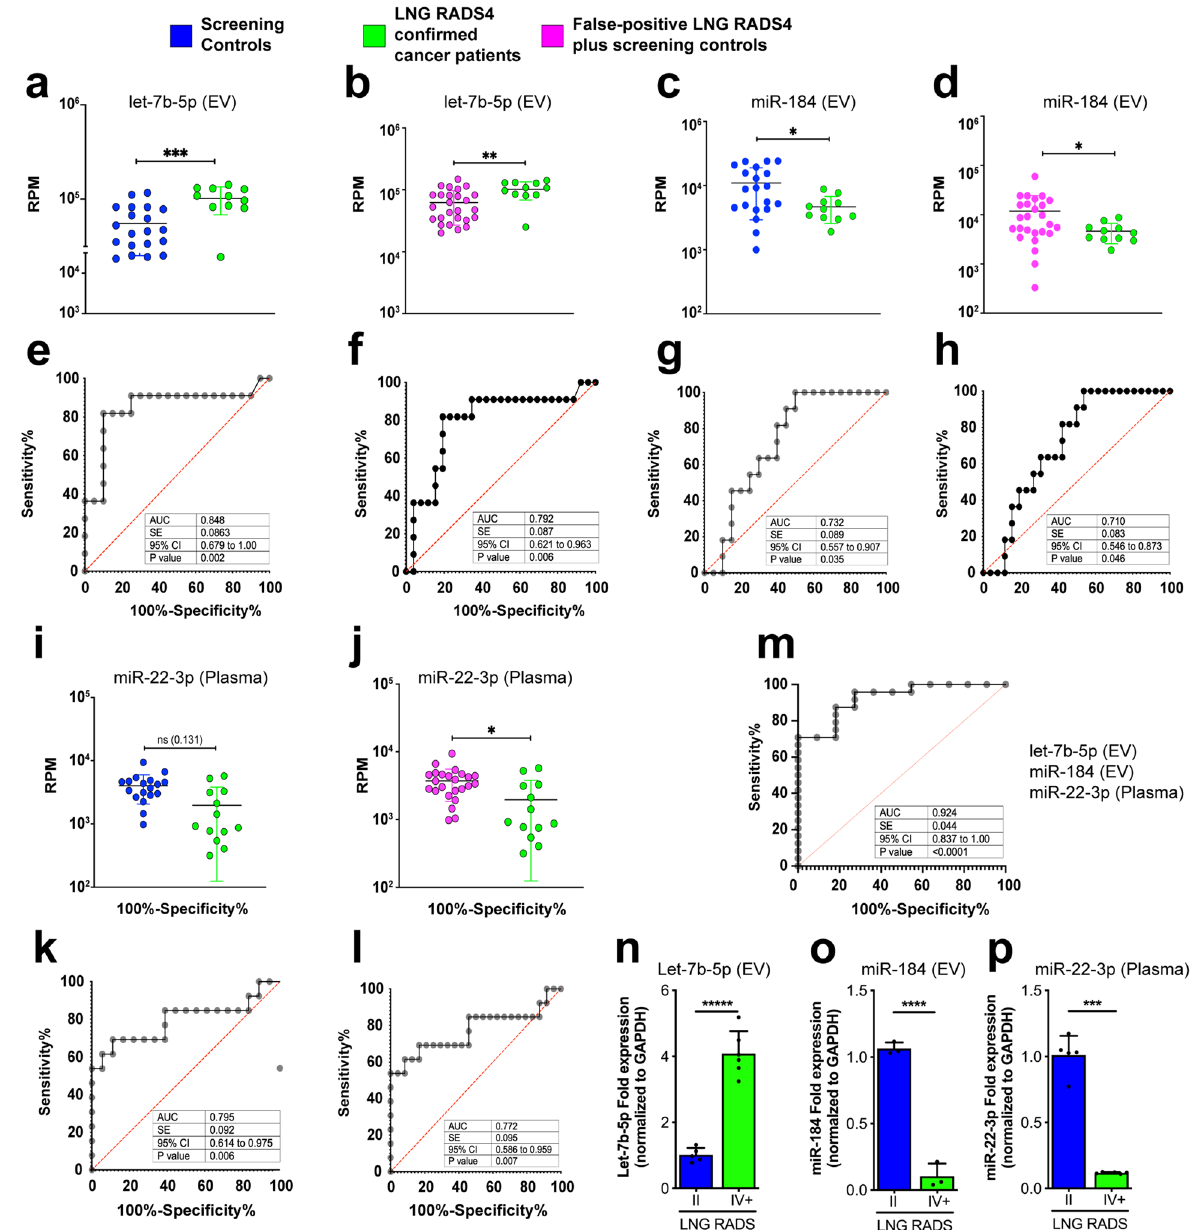
Figure 2. Identification of unique EV and circulating miRNA profiles Lung-RADS4 cancer patients. (a-l) Next Generation Sequencing (NGS) of blood EV or circulating miRNA identified Let-7b-5p, miR-184, and miR-22-3p as differentially expressed in NSCLC patients compared to controls. Let-7b-5p ( a , b ) and mir-184 ( c , d ) are deregulated in EV and mir-22-3p in plasma ( i , j ). The relative abundance of the indicated miRNA in screening controls (blue) versus confirmed diseased patients only (green) or versus all lung-RADS2 plus false- positive lung-RADS4 (magenta) are shown in ( a – d ) and ( i , j ), respectively. P values were Benjamini–Hochberg adjusted. * p < 0.1, ** p < 0.05, *** p < 0.01, **** p < 0.001. Note that 2–3 patient samples with undetectably low reads were excluded from the analysis. Corresponding Reads per million (RPM) were used to plot miRNA levels in confirmed cancer patients versus disease-free individuals and to perform ROC analysis shown in ( e – h , k , l ). EdgeR generalized linear models (GLM) were used to assess significance of miRNA regulations. Multiple logistic regression analysis was performed to determine the combined classification performance of the three miRNA biomarker candidates ( m ). Statistical significance of miRNA regulations was determined by EdgeR GLM, as indicated above. ( n – p ) Quantitative Polymerase Chain Reaction (qPCR) data showing expression fold changes (means) of let-7b-5p ( n ) or miRNA-184 ( o ) or miRNA-21-5p ( n ) or miRNA-22-3p ( p ) in EV samples obtained from confirmed cancer patients (IV +) versus screening controls (II). RNA samples were pooled from 14 cancer patients and 14 randomly selected screening individuals. Expression was normalized to GAPDH . Error bars denote SD values. P values are derived from student t-test